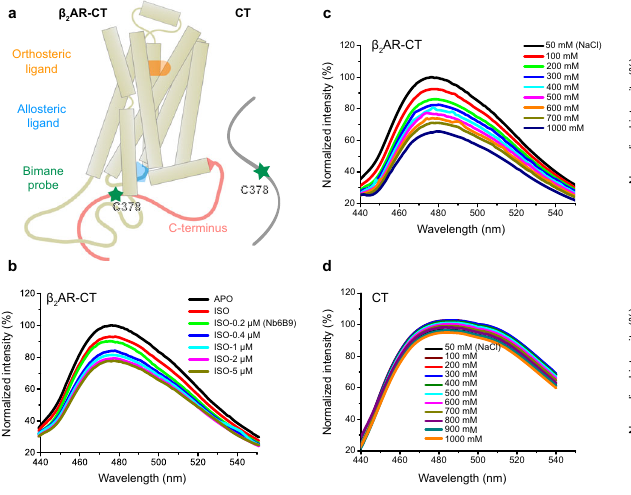
c Increasing sodium chloride concentrations decrease bimane intensity in the apo Fig. 5 | Monitoring interactions between the CT and the cytoplasmic surface β witha fl uorescentprobeboundtoC378.a Modelofbimanelabeled β 2 AR-CTand 2 AR-CT. d The effect of sodium chloride concentration on bimane-labeled CT. e Increasingconcentrationsofthecmpd-6combinedwithsaturatingisoproterenol CTatC378.Theorthostericligandusedinthisexperimentisisoproterenol,andthe allosteric ligand is cmpd-6. b Increasing concentrations of Nb6B9 in combination result in a decrease in the bimane intensity of the β 2 AR-CT. f The effect of cmpd-6 with saturating isoproterenol result in a decrease in the bimane intensity of the concentrations on bimane-labeled CT. g Nucleotide-free Gs reduces the bimane fl uorophore moves to a more polar environment. β intensity of the β 2 AR-CT. h Gs doesn ’ t affect the intensity of bimane-labeled 2 AR-CT, suggesting that the